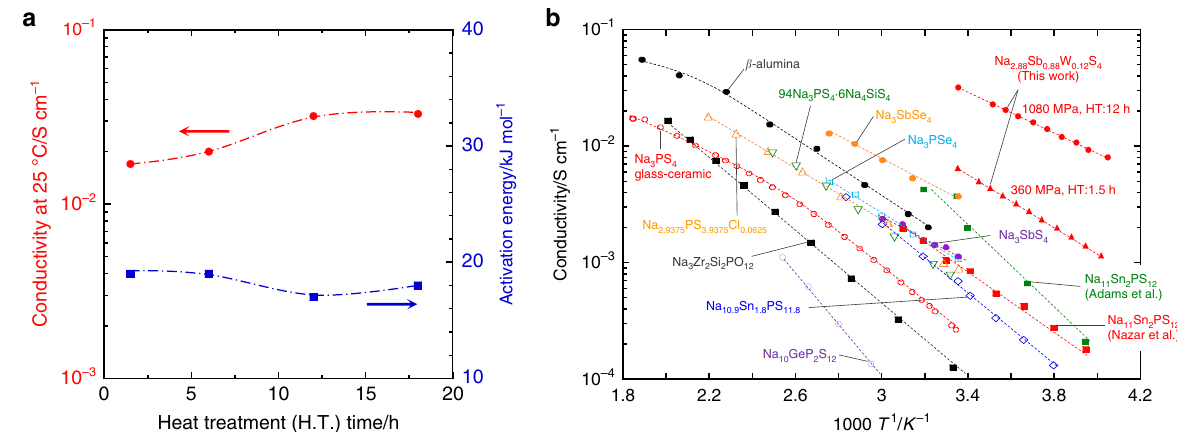
Fig. 3 Conductive behavior of Na 2.88 Sb 0.88 W 0.12 S 4 electrolyte. a Conductivity at 25 °C ( σ 25 ) and activation energy E a for the conduction of the pelletized Na 2.88 Sb 0.88 W 0.12 S 4 electrolytes as a function of heat treatment (H.T.) time at 275 °C. The pellets were prepared by cold-pressing the electrolyte powder